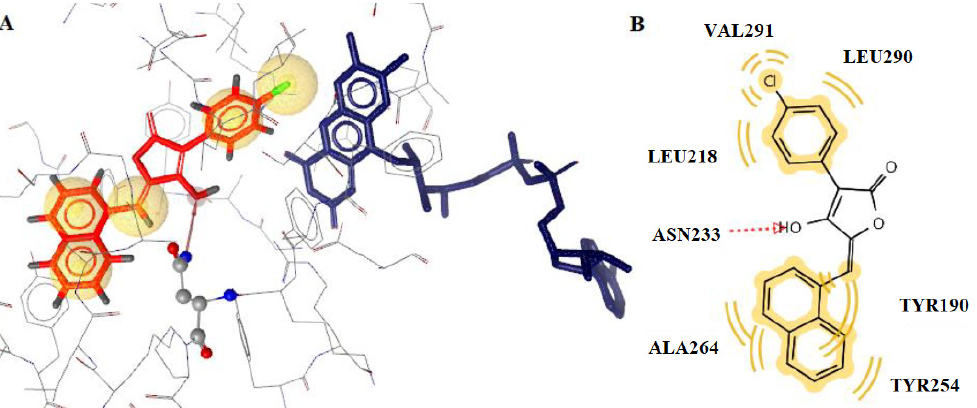
Figure 4. ( A ) Superposition of Naphthyl Tetronic Acid inhibitor (red) and FAD (blue) in E. coli MurB. ( B ) Docked conformation of Naphthyl Tetronic Acid inhibitor in E. coli MurB. Red dotted arrows indicate H-bond and yellow spheres hydrophobic interactions.